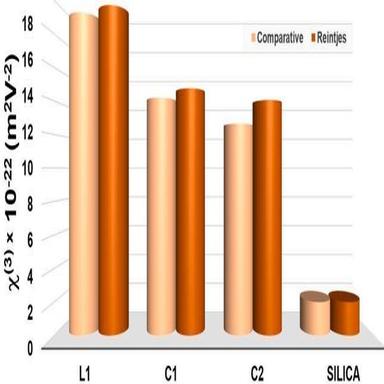
Histogram presenting values of the second-order nonlinear susceptibility for the L1, C1 and C2 thin films calculated via theoretical models: comparative and proposed by Reintjes.